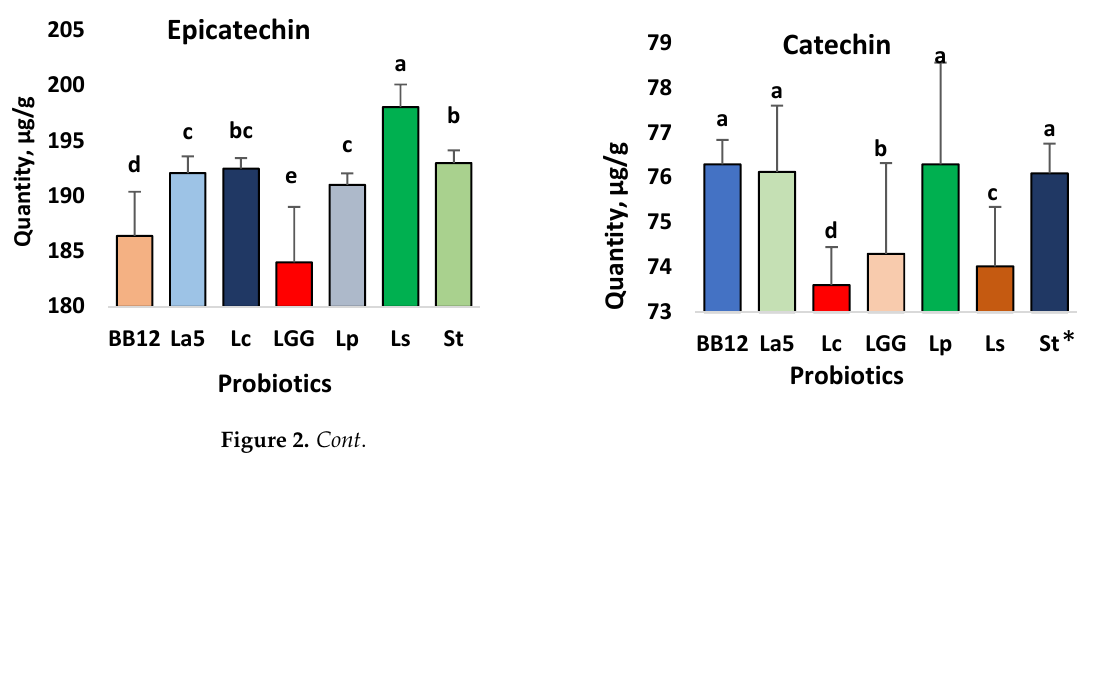
A B Figure 2 . Interactive effect of major polyphenols in 70% ( A ) and 45% ( B ) cocoa chocolates through simulated in vitro gastrointestinal digestion and colonic fermentation . * BB12: B. animalis spp. lactis ,